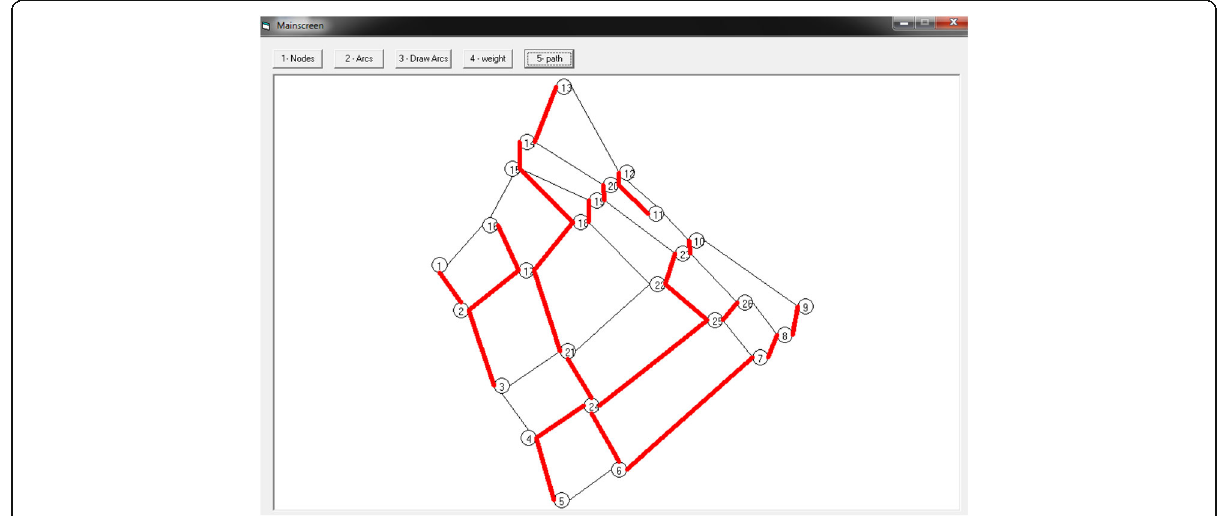
Fig. 23 The Results Derived from Implementing the Model of Safety Index on the Sample Data using